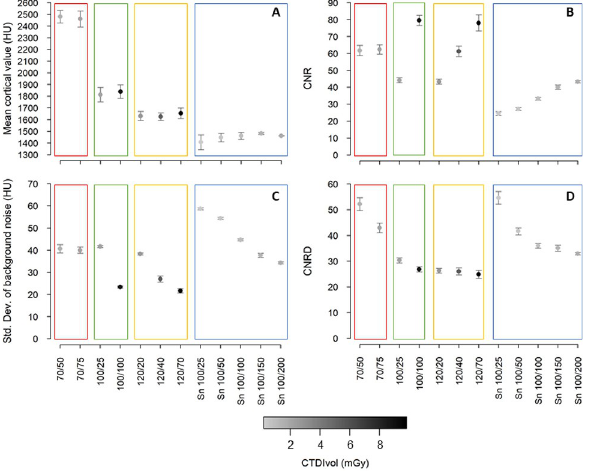
Fig 3. Scatterplot of objective image evaluation. Shown are mean cortical values (A), CNR (B), standard deviation of background noise (C) and CNRD (D). Symbols represent the mean and error bars the standard deviation of triplicate ROI measurements. The symbol of each protocol is color coded according to the color scale based on the CTDIVol on the bottom of the figure: the darker the grey, the higher the CTDIVol. Colored rectangles refer to the different tube voltages examined: Red = 70 kV, green 100 kV, yellow = 120 kV and blue = Sn 100 kV. CNR = contrast-to-noise ratio, CNRD = dose-weighted contrast-to-noise ratio, CTDIVol = computed tomography dose index, HU = hounsfield units, ROI = region of interest, Std.Dev. = standard deviation, Sn = tin filter.